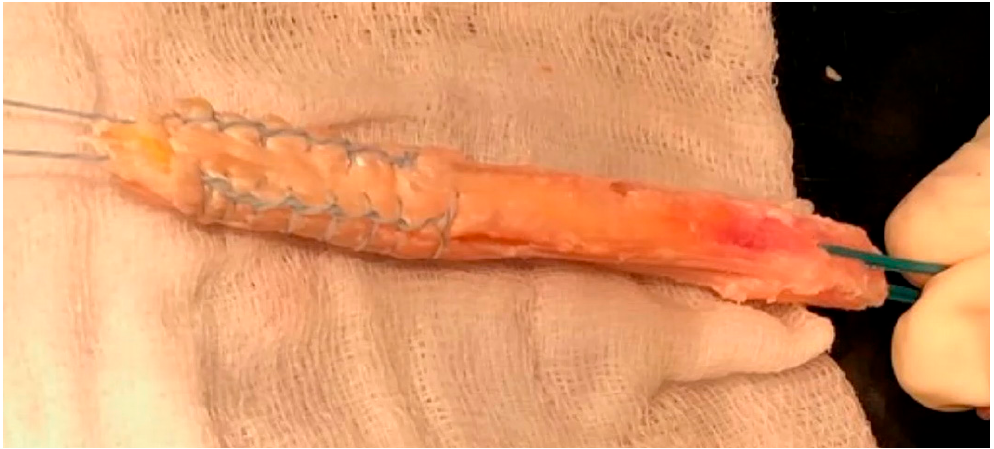
Figure 1. Quadriceps tendon bone full-thickness autograft.